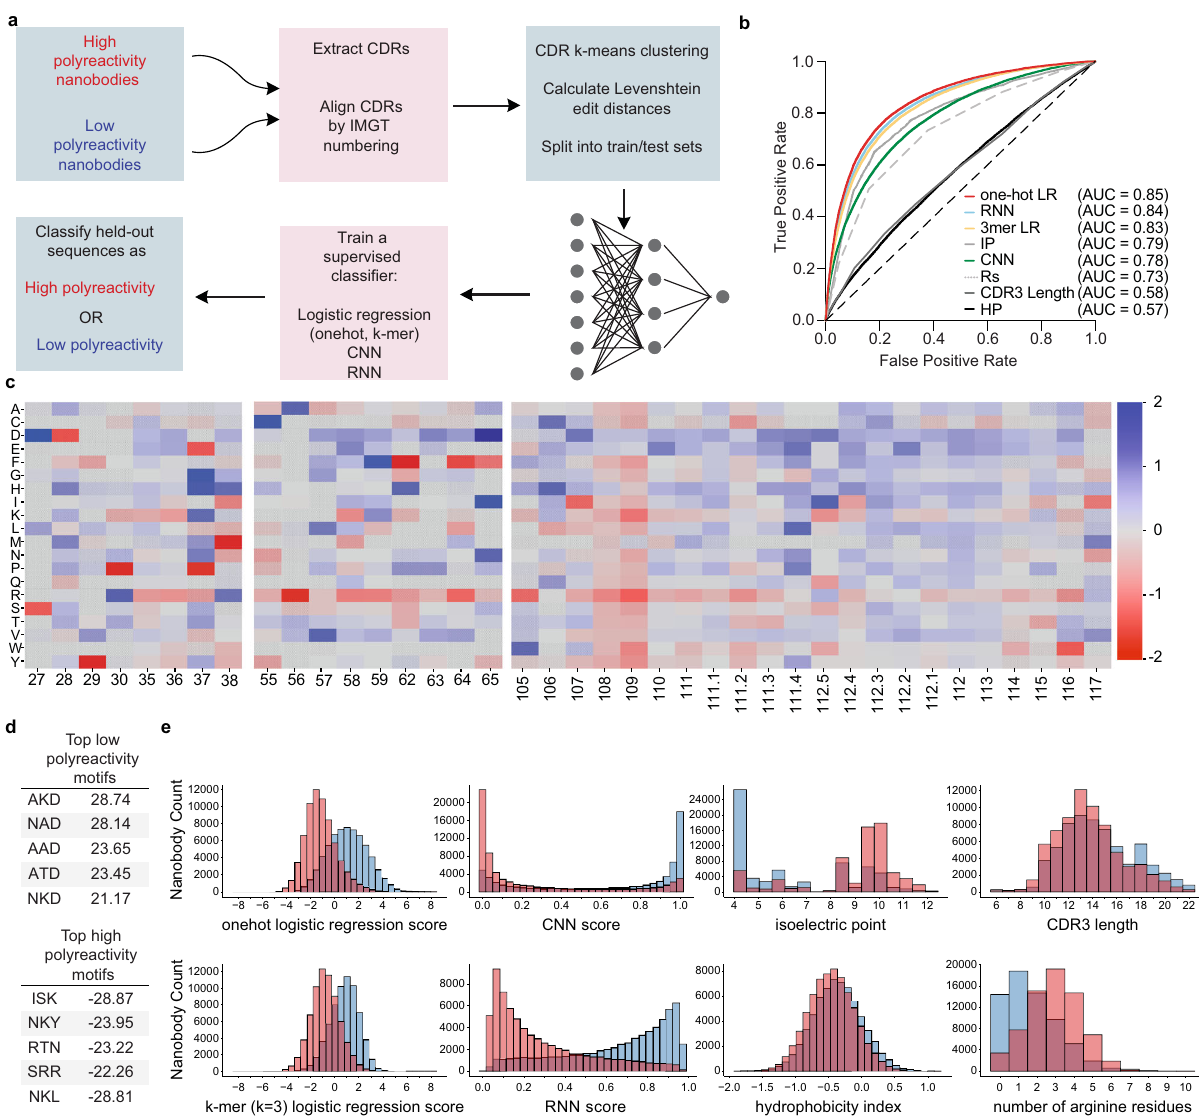
Fig. 3 | Development of computational models to predict polyreactivity. Supervisedmodelsweretrainedonpoolsofhighandlowpolyreactivitysequences. a Pipeline of computational model development from raw NGS data to held-out predictions with sequence clustering for rigorous validation. b Comparison of supervised models (one-hot and k-mer logistic regression, RNN, CNN) and bio- chemical properties such as hydrophobicity, isoelectric point, CDR3 lengths, and number of arginine residues. c Trainedparameters of a one-hot logistic regression